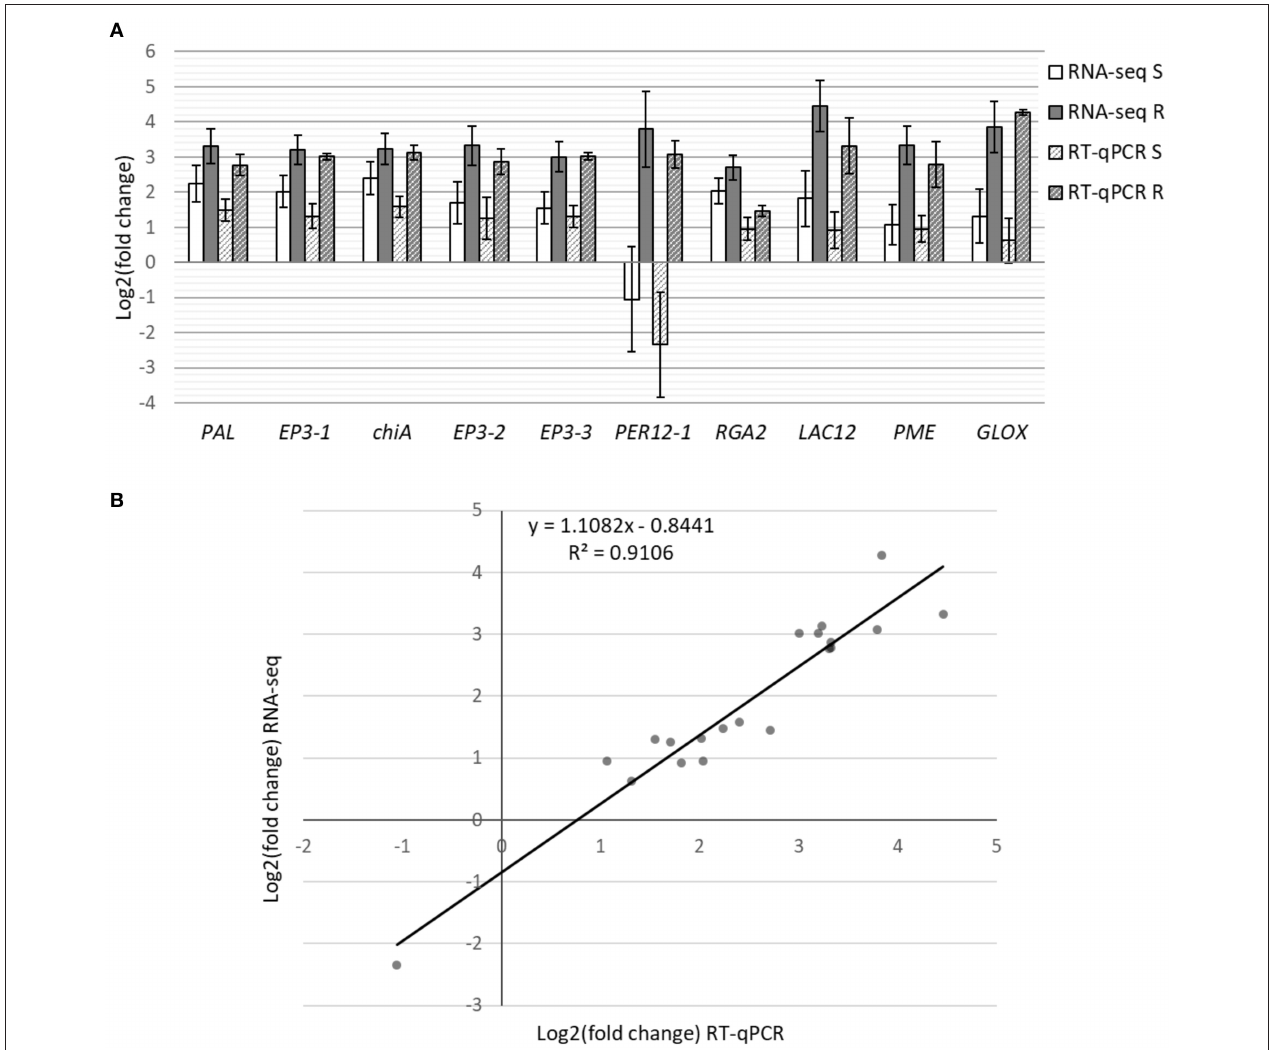
FIGURE 3 | RT-qPCR analysis of 10 DEGs from the RNA-seq results. (A) Bars represent differential expression levels, in log2(fold change), of susceptible (white) and resistant (gray) plants in comparison with controls. Results from both the RNA-seq analysis (filled colors) and the RT-qPCR analysis (stripes) are displayed. Error bars represent the standard error of the biological replicates used for RNA-seq (4–5) and RT-qPCR (3). (B) Correlation of expression levels between RNA-Seq and